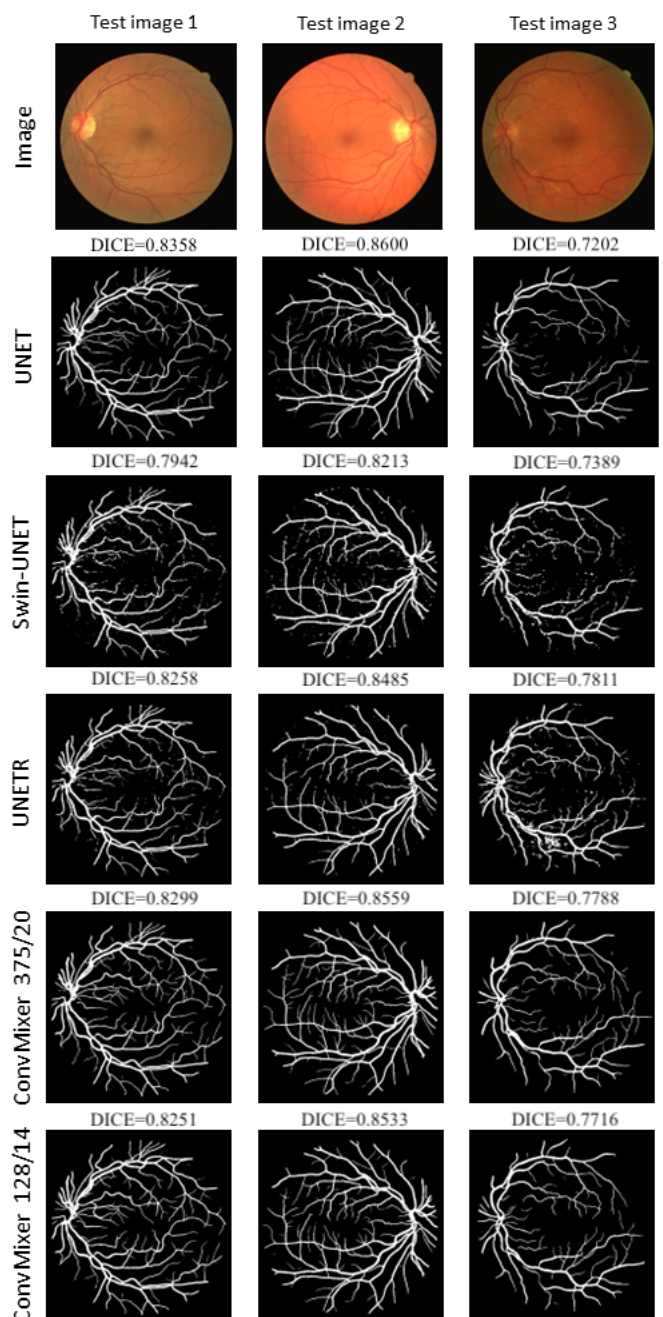
Figure 9. Prediction images and DICE scores of all the trained models in three of the test